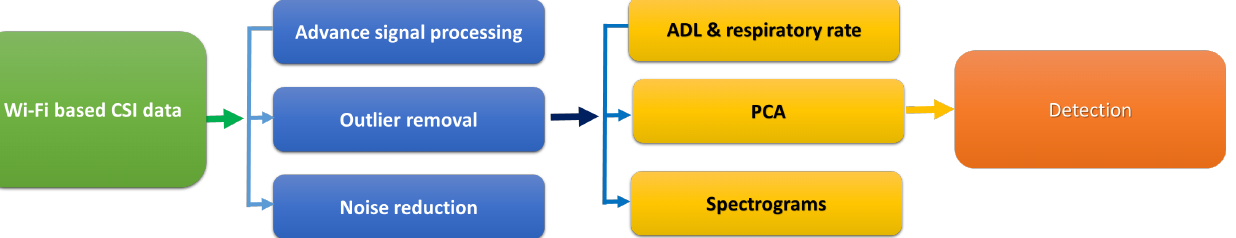
Figure 5. Work low of WiFi sensing for extracting ADLs and respiratory